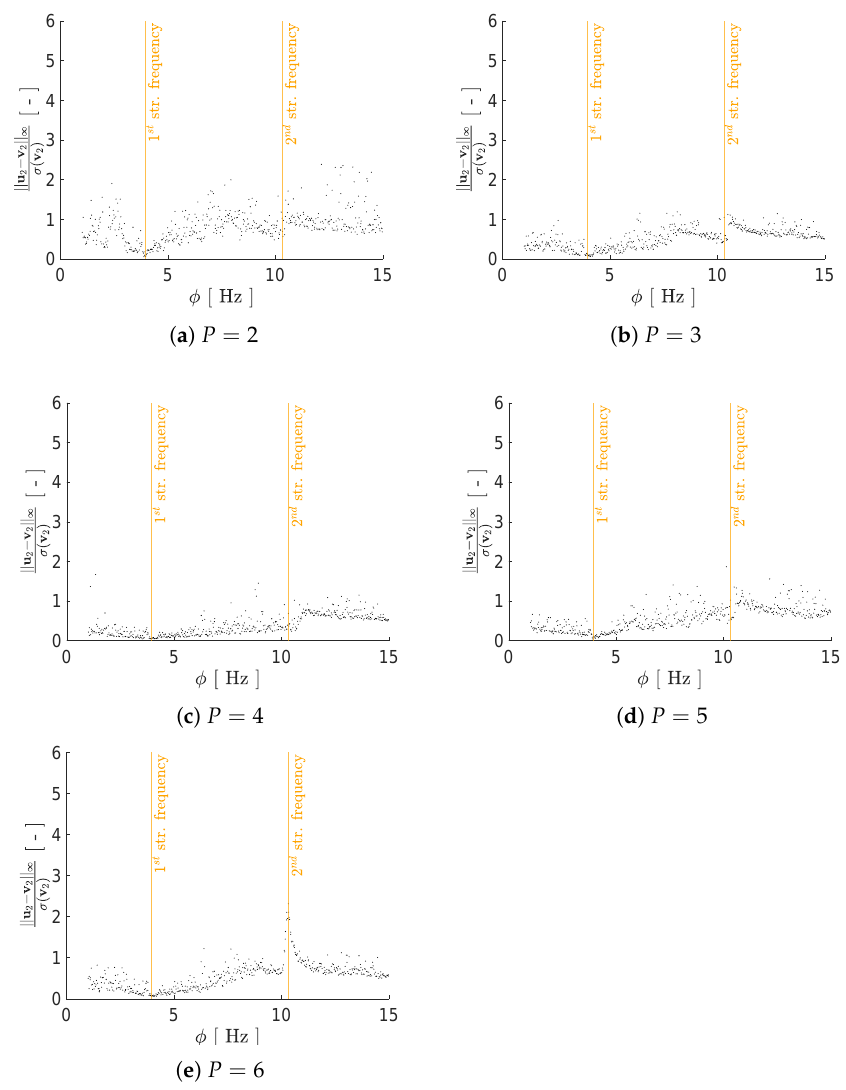
Figure 10. Two-storey shear building, configuration A. Reconstruction error for floor displacement v 2 via the standardized L ∞ norm, as a function of the load frequency φ and for a varying value of P . In the charts, the dots refer to the test set.